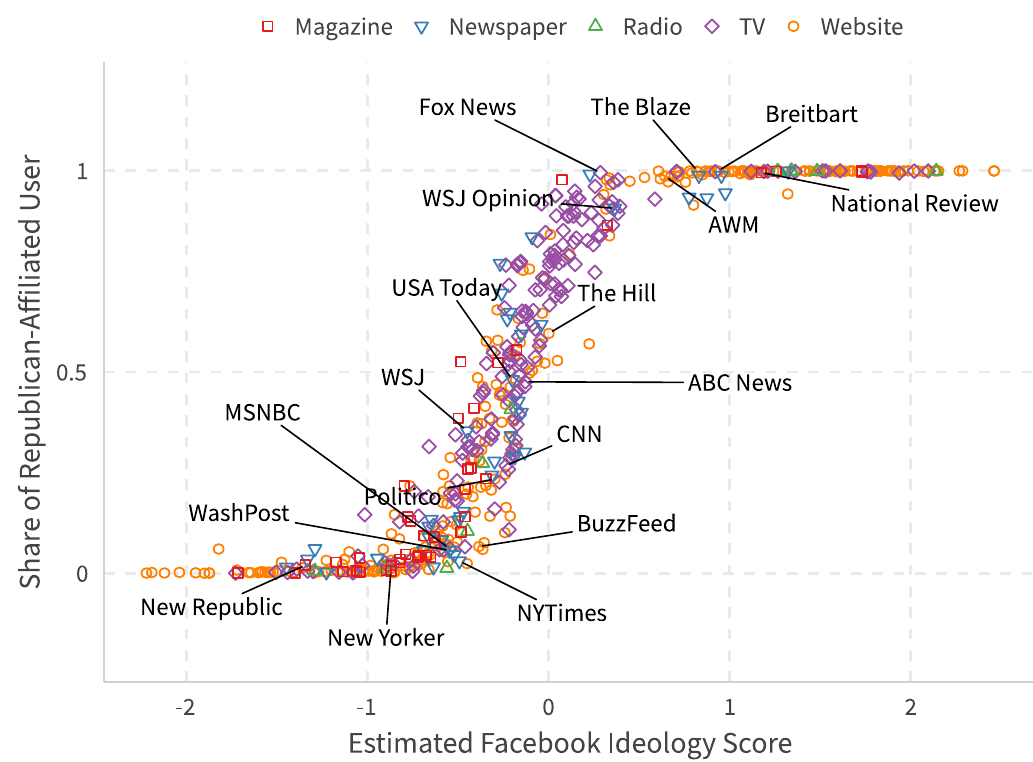
Fig 6. Validation of media slant. A user is Republican-affiliated if their likes in all politicians are more of Republicans. We only count user once a day on a page if they like more than one post on that day on that page. We then sum all this kind of daily users up across each day. Data ranges from 2015-01-01 to